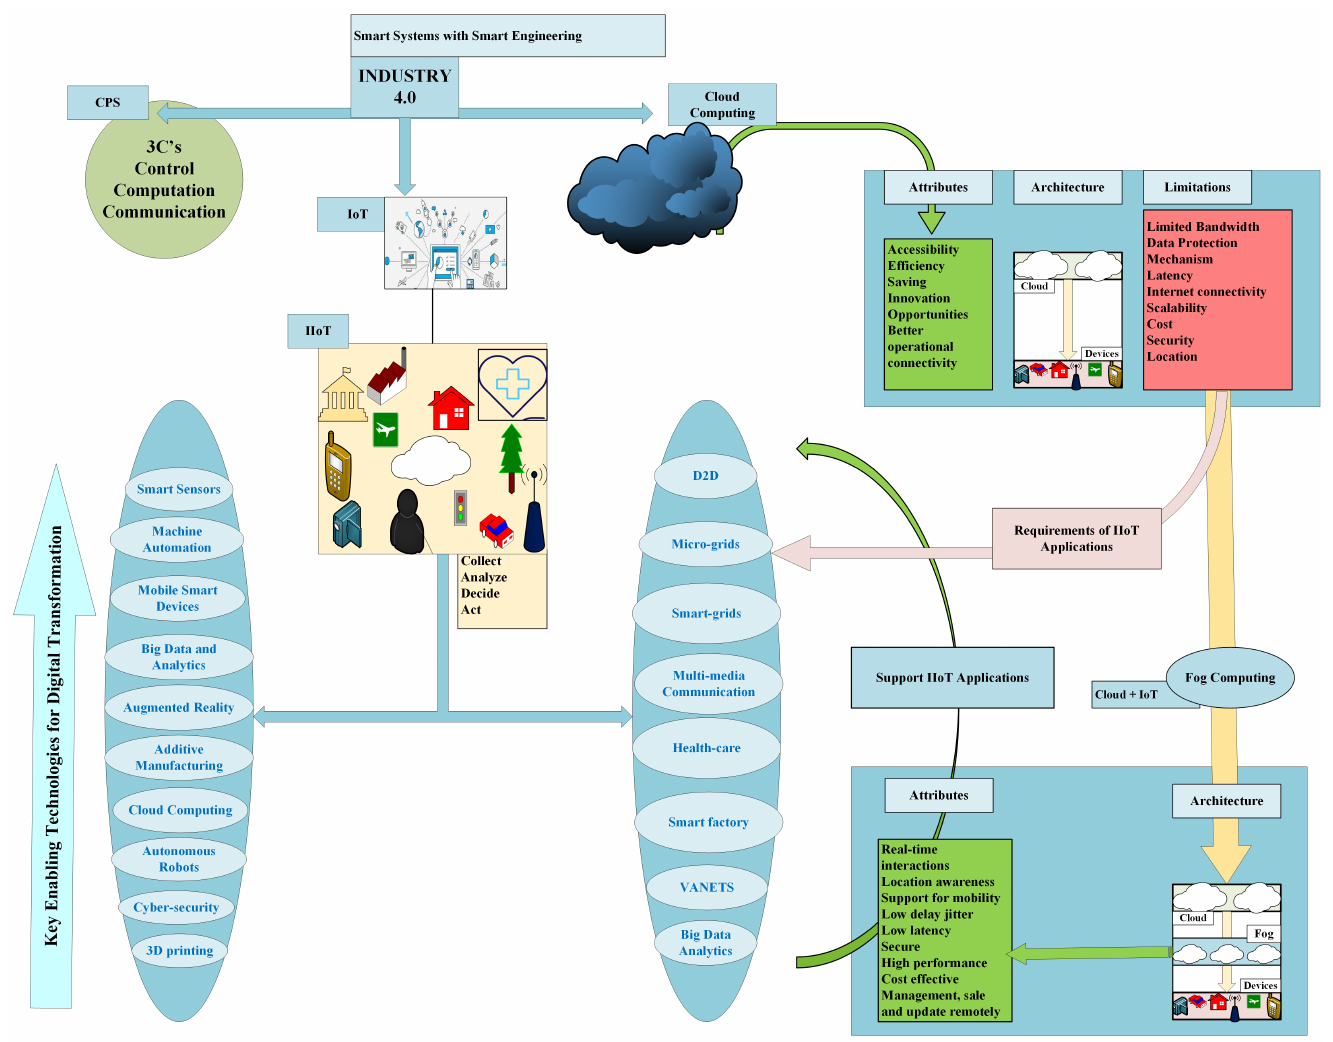
Figure 7. Industry 4.0, IIoT applications versus cloud and fog